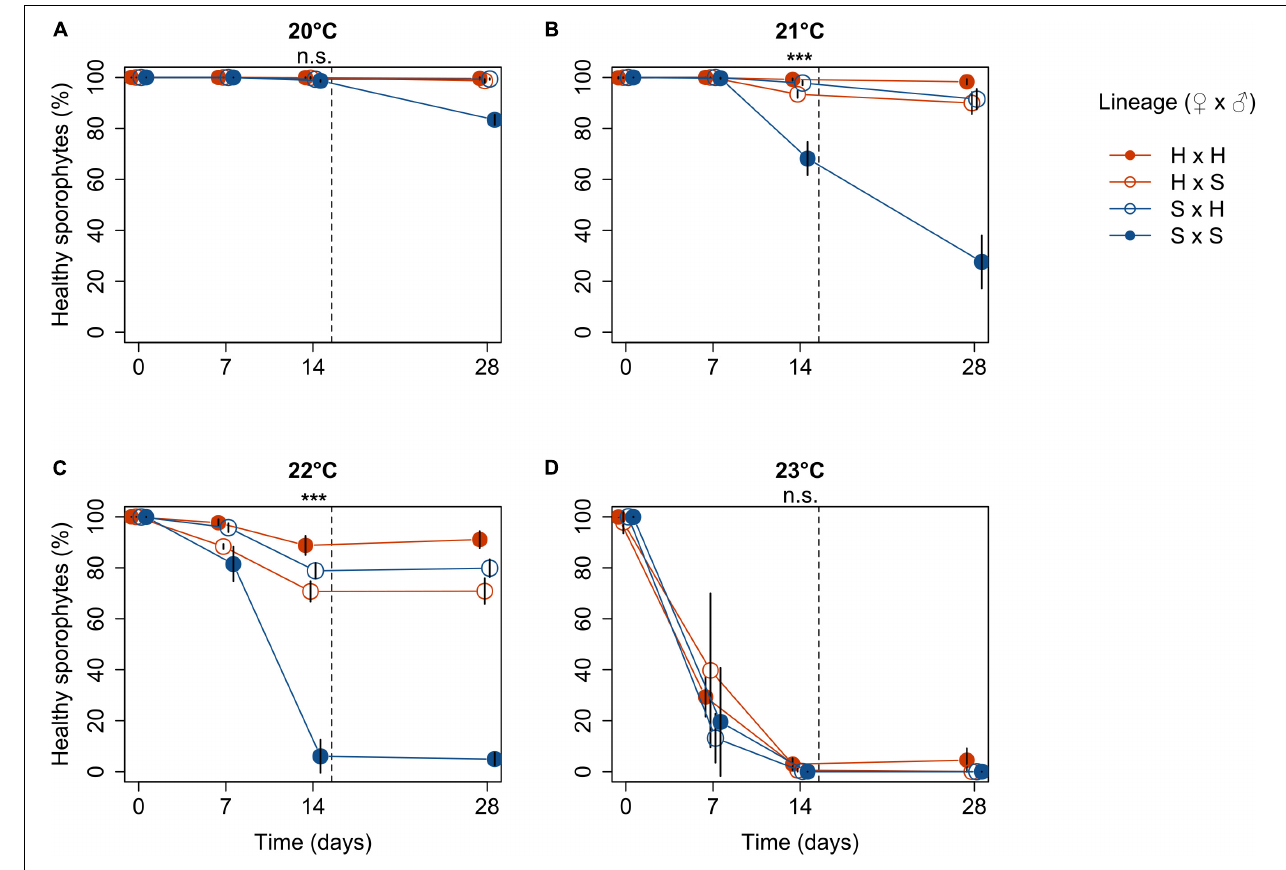
FIGURE 1 | Proportion of fully pigmented (healthy) Laminaria digitata microscopic sporophytes produced by crossing females × males from Helgoland (H) and Spitsbergen (S) in experiment 1 over 14 days in treatments of 20 ◦ C (A) , 21 ◦ C (B) , 22 ◦ C (C) and 23 ◦ C (D) followed by 14 days of post-cultivation at 20 ◦ C (separated by dashed line; mean values ± SD, n = 4). Significance of the fixed effect lineage on sporophyte health after 14 days of temperature exposure is indicated above each panel (ANCOVA; ***, p < 0.001; n.s., not significant). For pairwise comparisons, see main text.